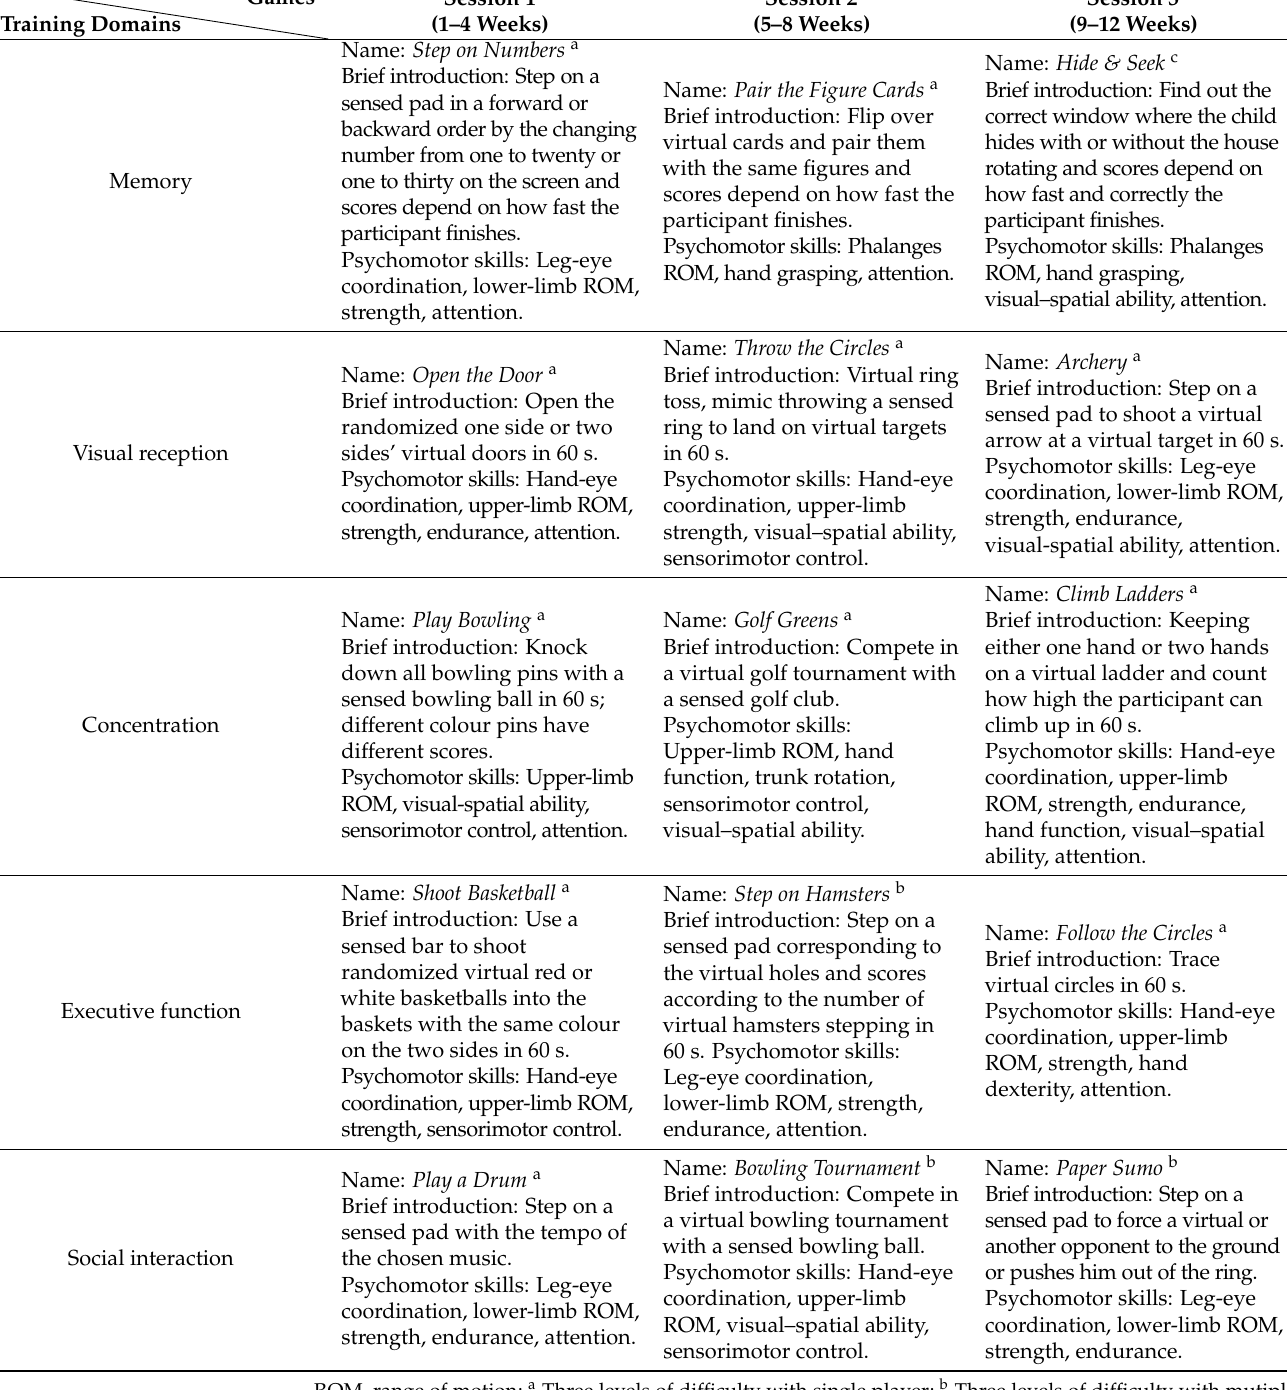
Table 1. Interactive-video games training